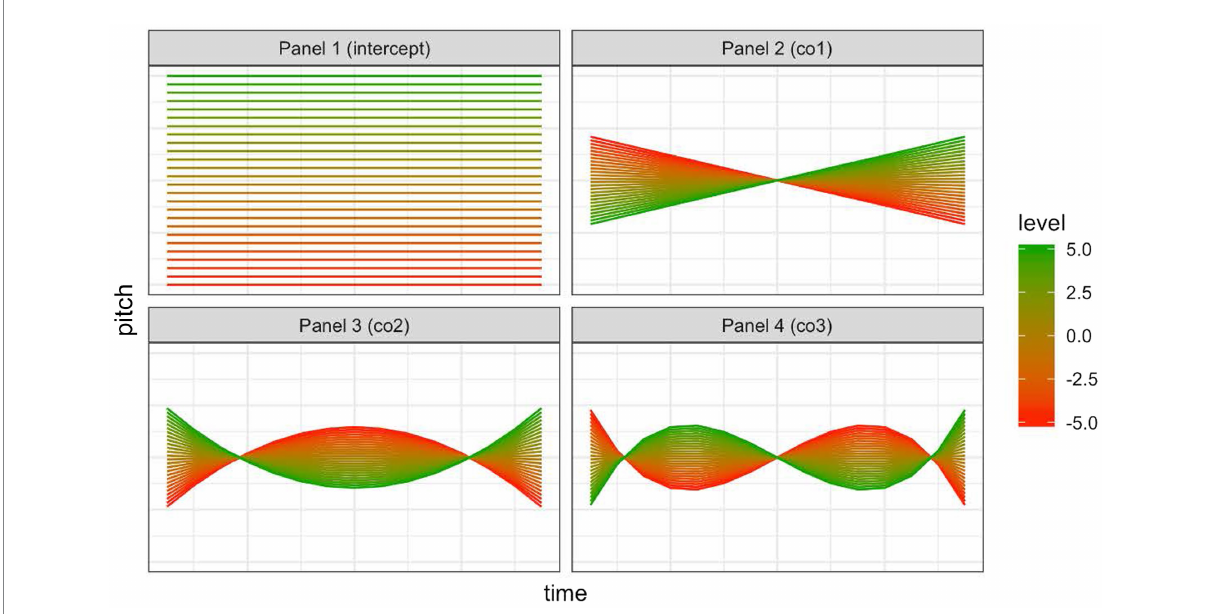
FIGURE 1 Parameters in SOCoPaSul. This figure shows, in each of the four panels, the effect on the contour shape of changing each parameter from a high value (green) to a low value (red), whilst holding the values of all the other parameters constant. Panel one depicts variation of the intercept (pitch level), panel 2 and panel 4 depicts variation in the rising or falling direction of the intonation contour and the peak alignment (CO1 and CO3), panel 3 controls peak shape, from convex to concave